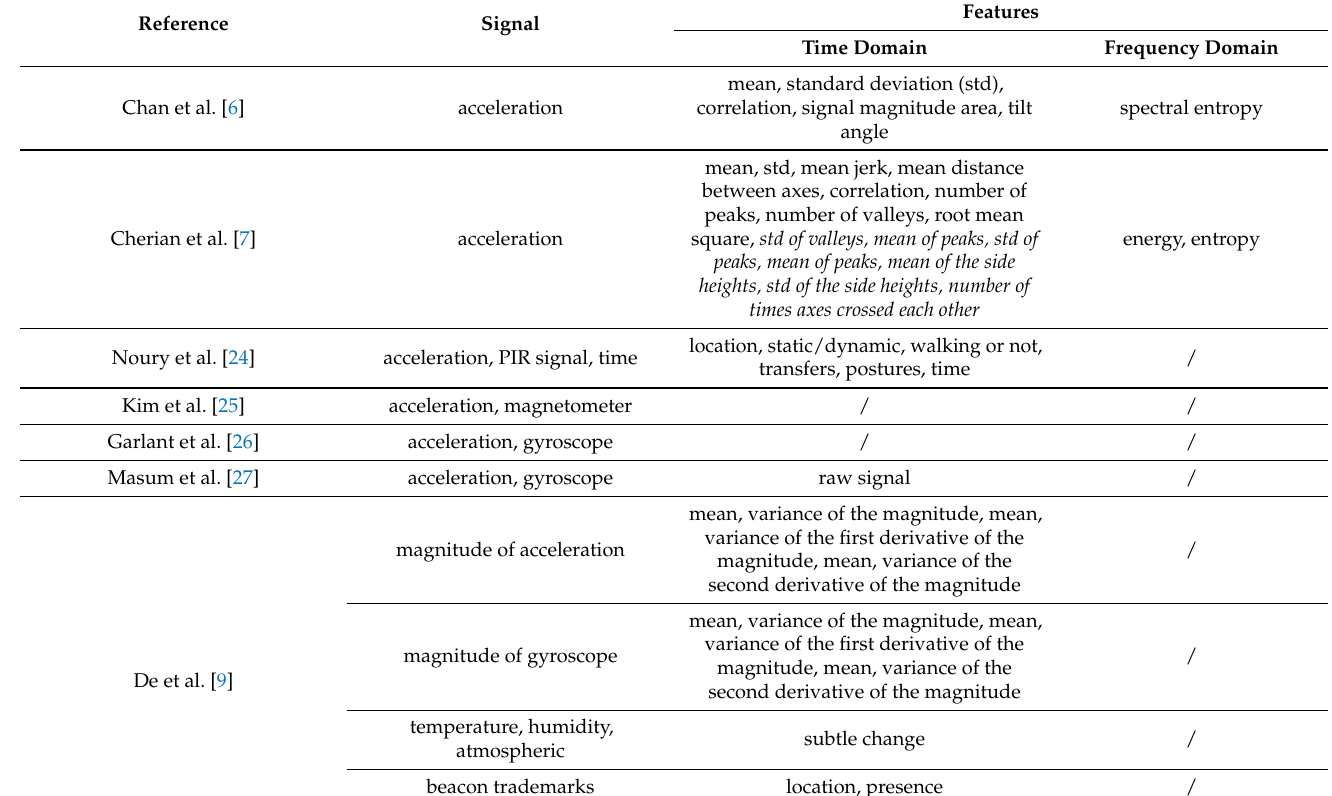
Table 4. Handcrafted features (time and frequency domain) for activity